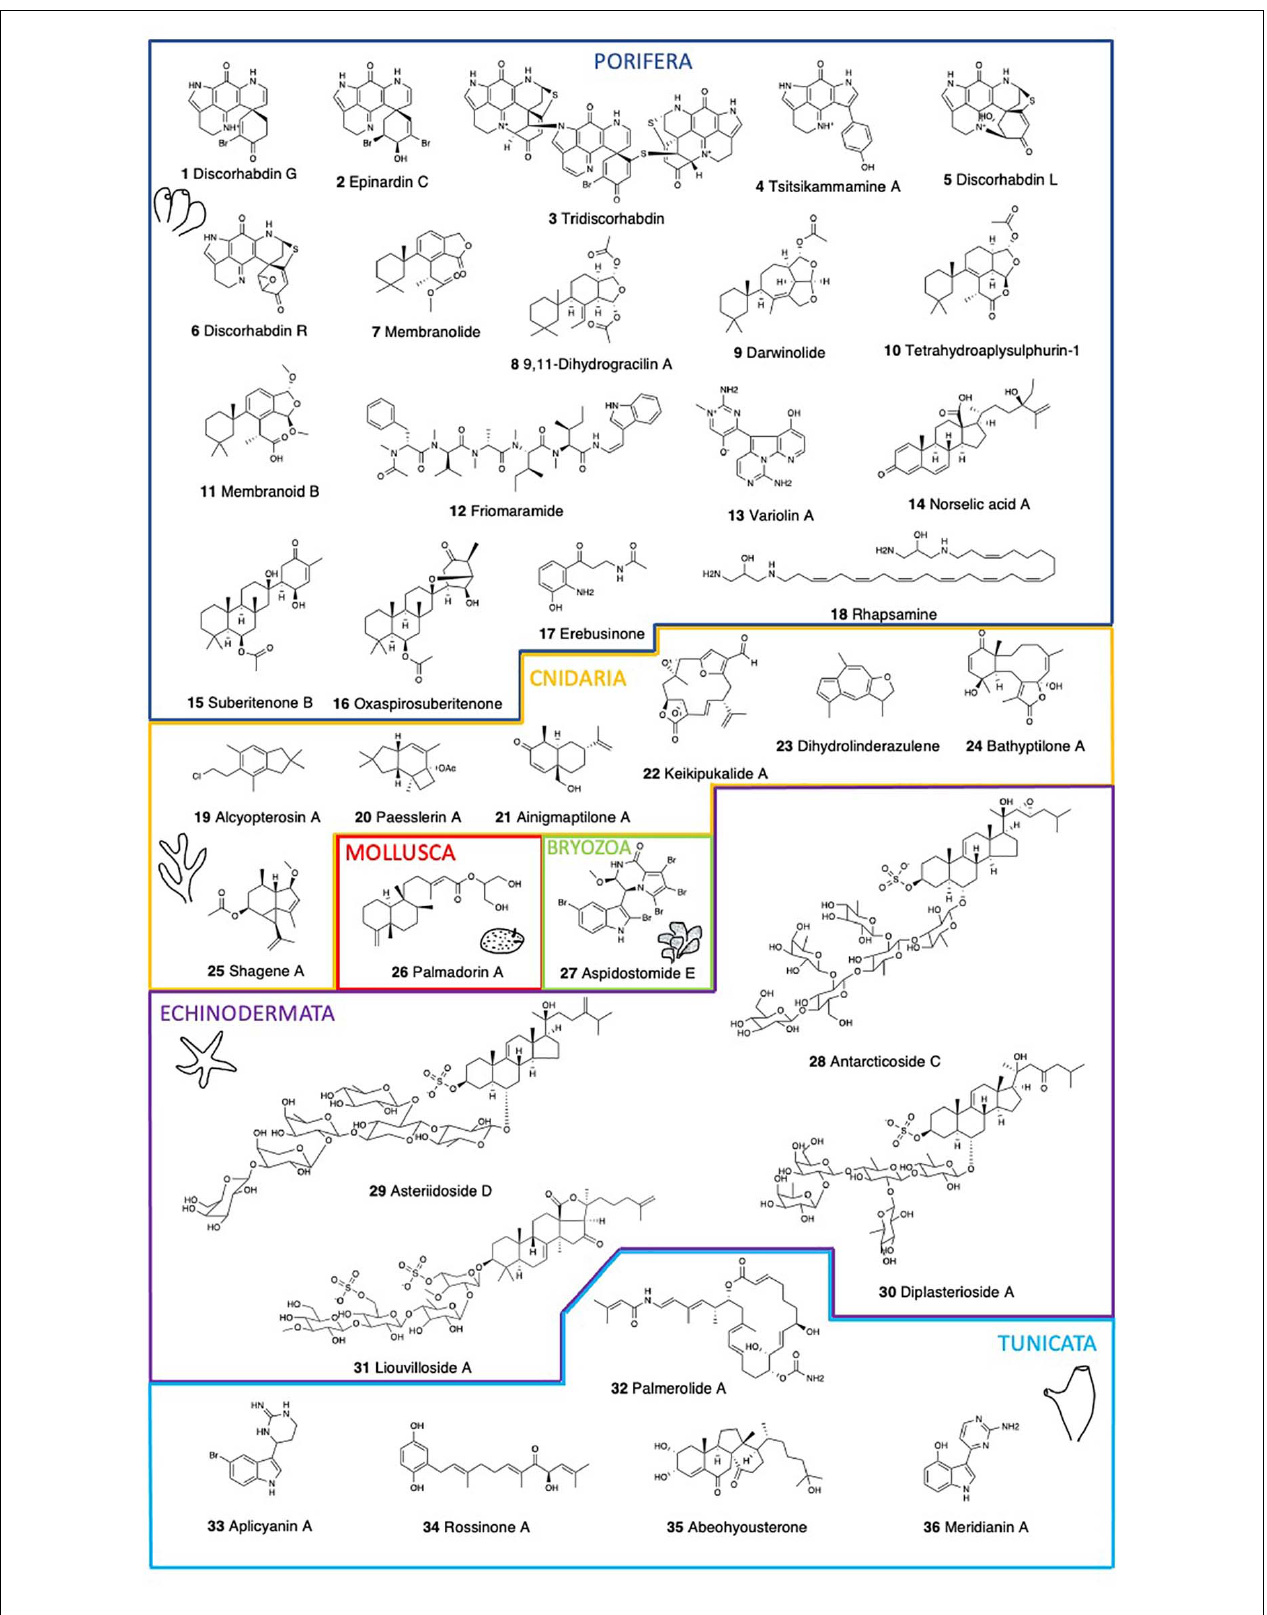
FIGURE 1 | Chemical structure of the main bioactive compounds described in Antarctic marine benthic invertebrates.